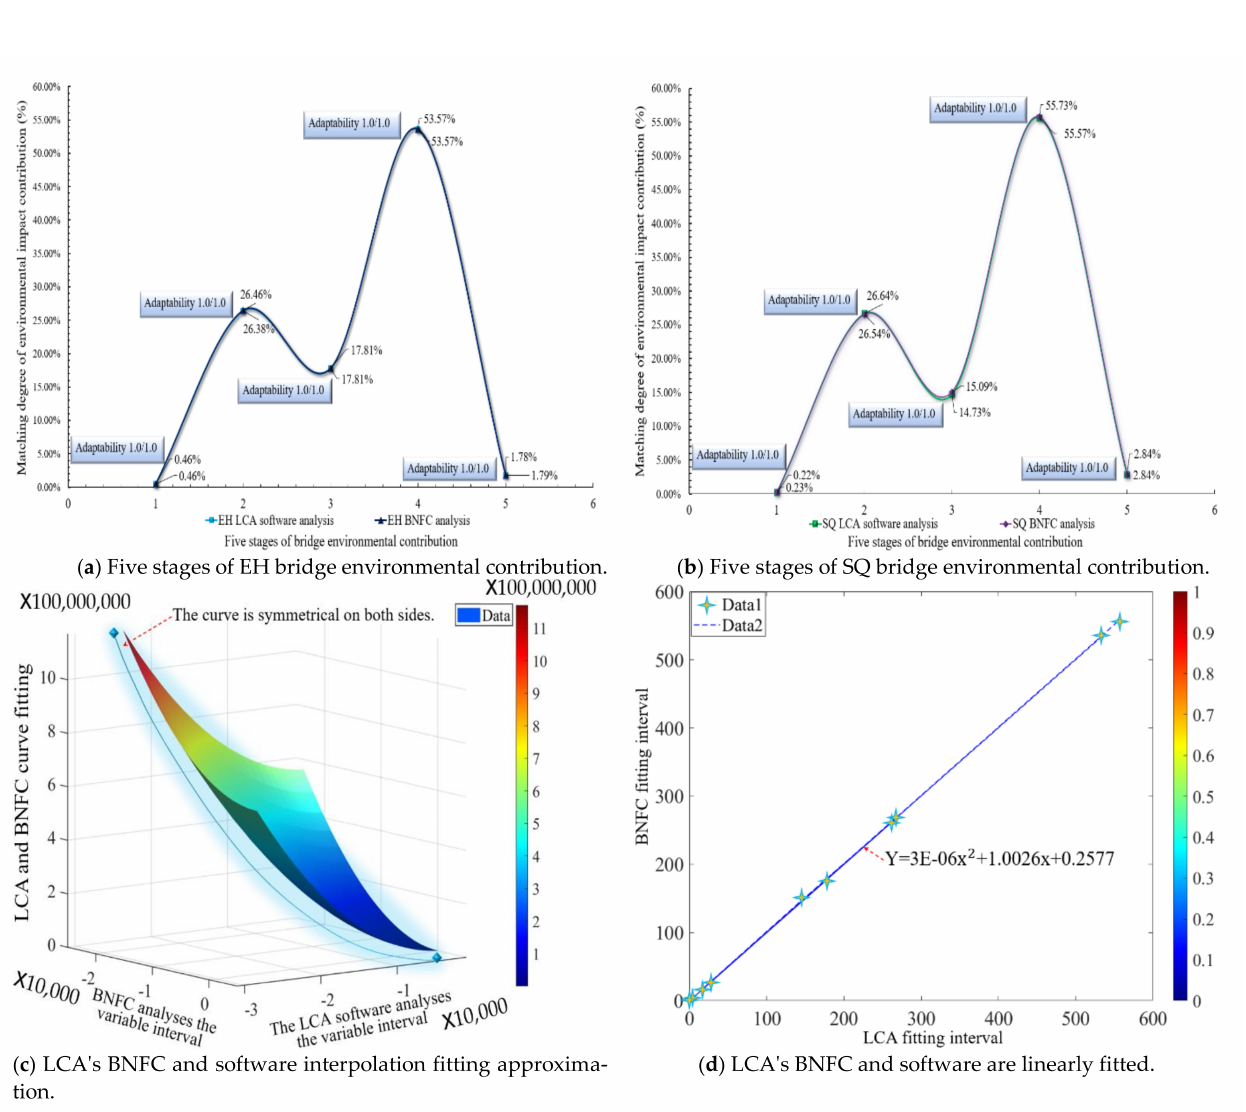
Figure 10. The matching degree of the contribution of SQ and EH to the environmental impact is fit to the numerical curve. To facilitate comparative analysis, Equations (2)–(4) and (5) are transformed, and